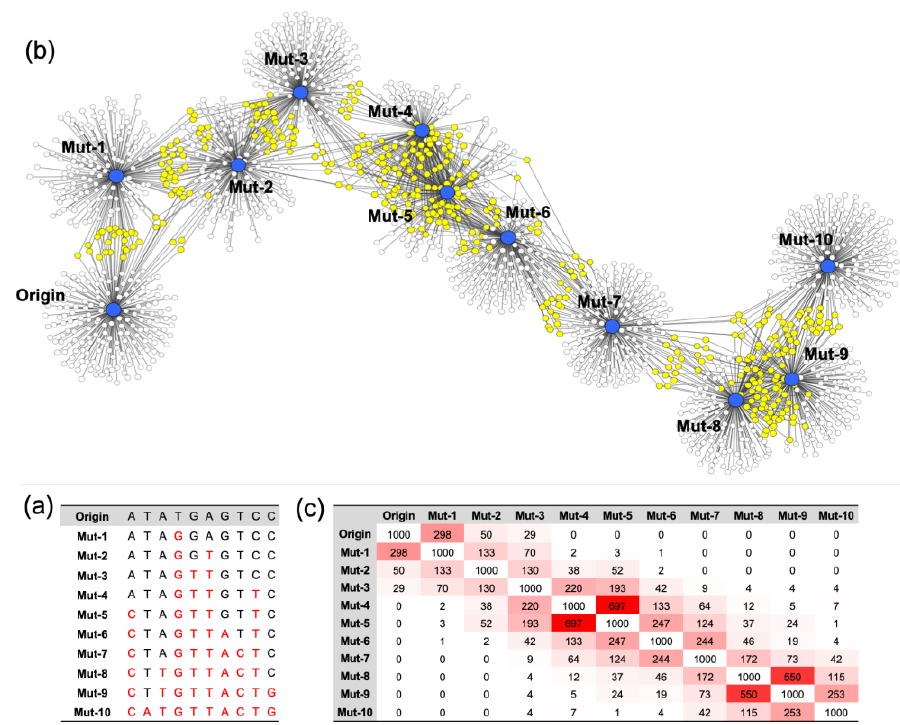
Figure 1. The sequence information and the sociogram of the origin and its mutants. ( a ) The sequences of the mutants were randomly generated by changing the bases of the origin in a cumulative manner. Mutants were created, and the number of each is noted after “Mut-.” ( b ) The origin and the mutants are marked as nodes (blue circles). The top 100 rated complementary sequences (white circles) with the lowest Gibbs free energy were linked with their complements. The complementary sequences have more than two linkages, and are marked as yellow circles. ( c ) For measuring the number of shared complementary sequences (Closeness), 1000 sequences with the lowest Gibbs free energy were used. The closeness of sequences is noted in the table. The cells with a higher number of sequences are marked with a reddish